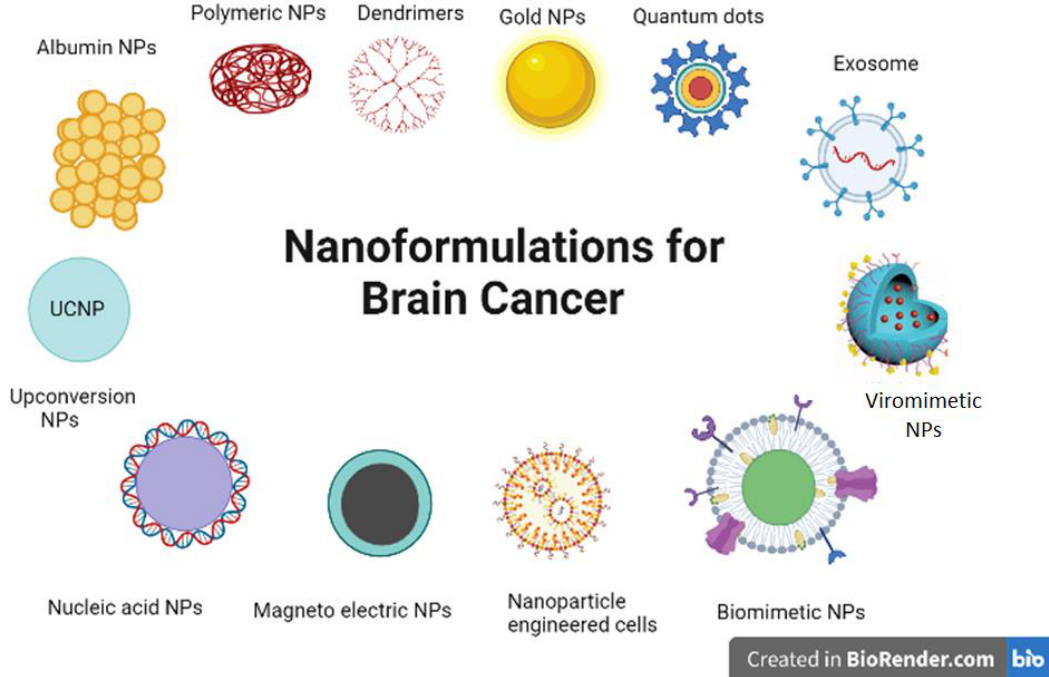
Figure 2. Novel nanoplatforms currently under research for neuro-oncology applications. The figure illustrates some of the major categories of nanoplatforms that are currently being researched for improved and effective diagnosis and therapy of brain cancers.